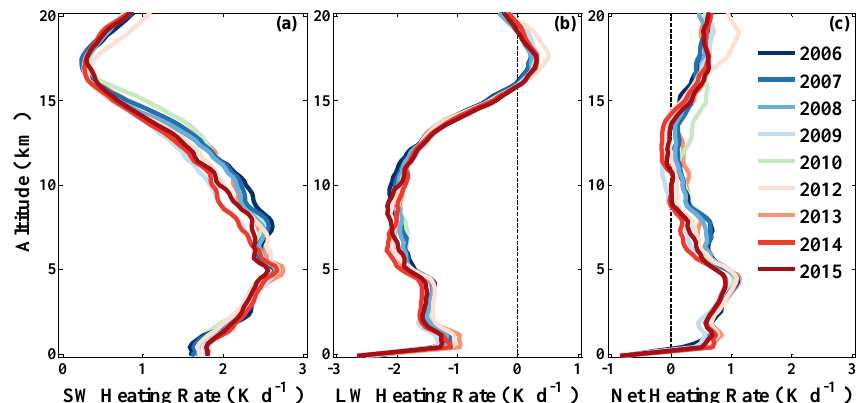
Figure 4. Temporal variations in spatial average vertical ( a ) SW, ( b ) LW, and ( c ) net heat rating in all-sky conditions from CloudSat during the monsoon season in South Asia from 2006 to 2015.